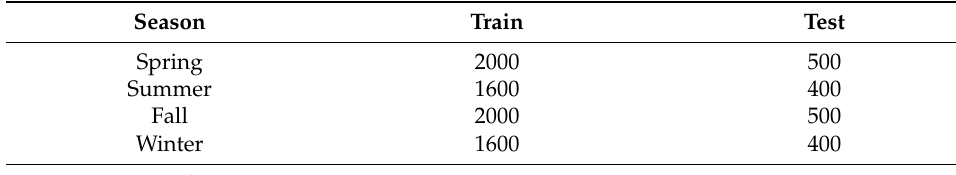
Table 1. The number of different season types in our selected dataset.